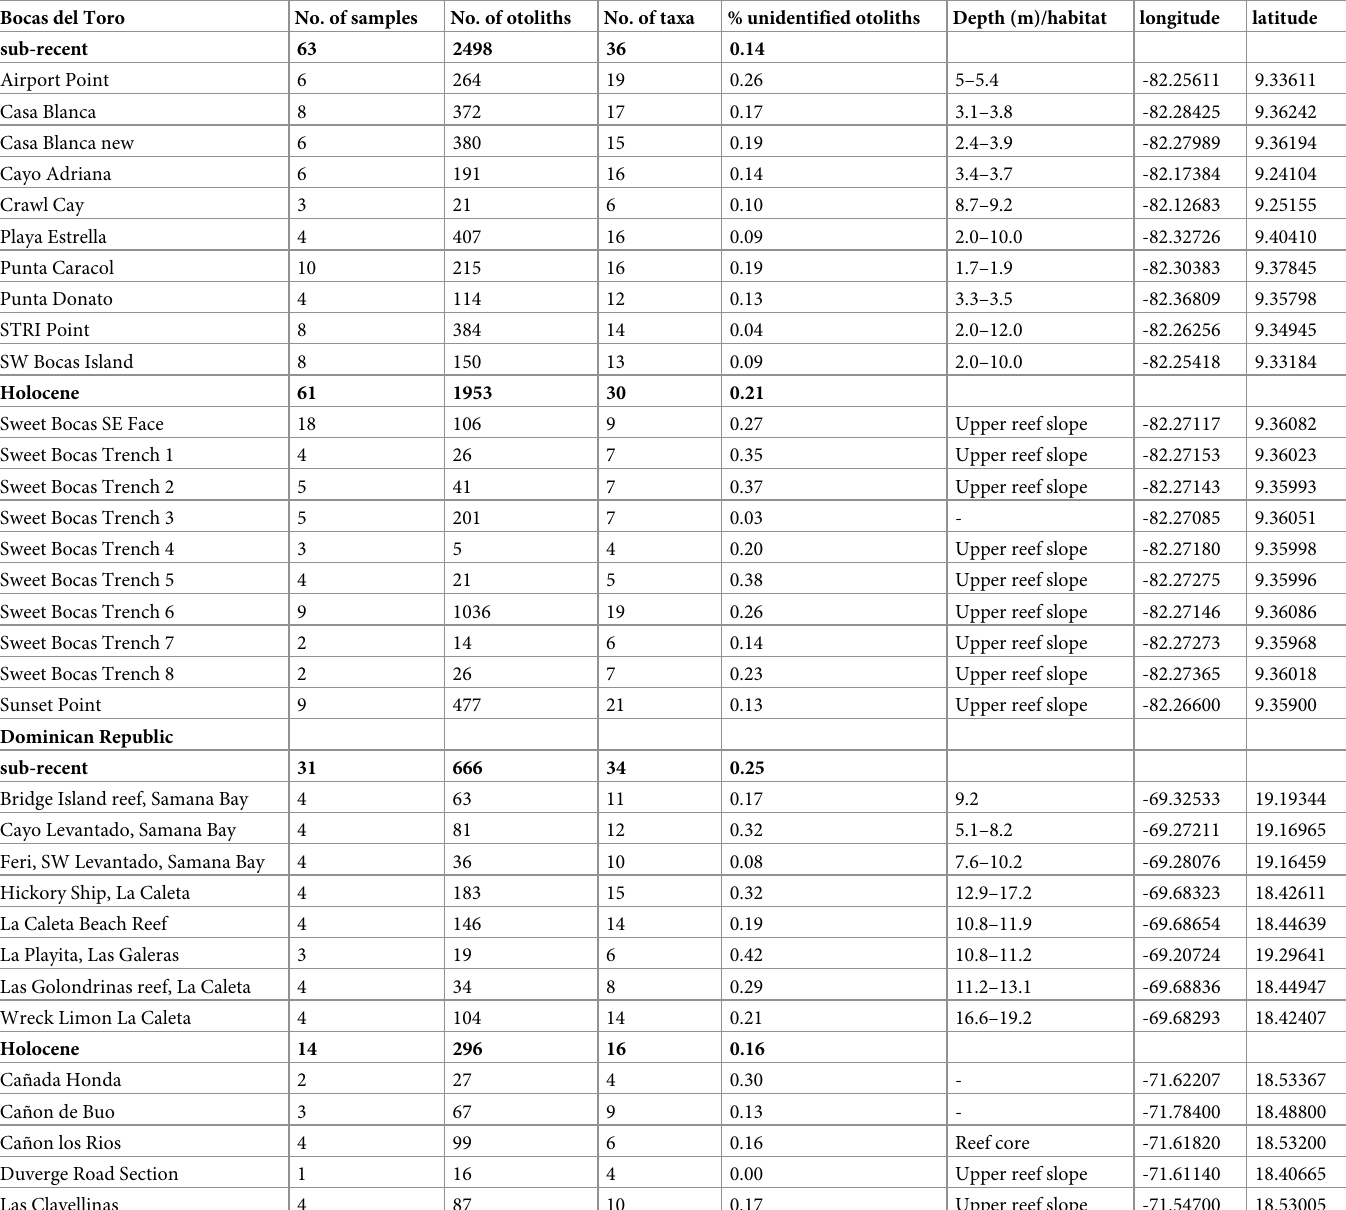
Table 1. Location and general information of sediment sampling